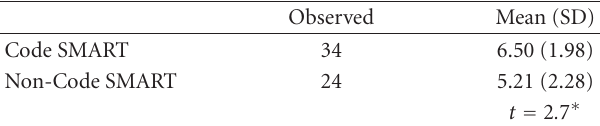
Table 2: Di ff erence of means test for compliance with sepsis